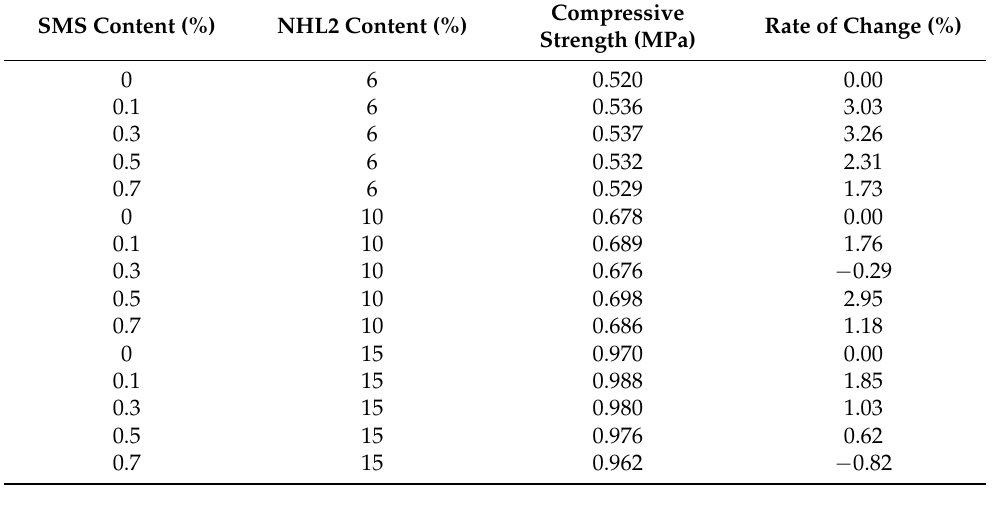
Table 6. Unconfined compressive strength of composite modified materials.